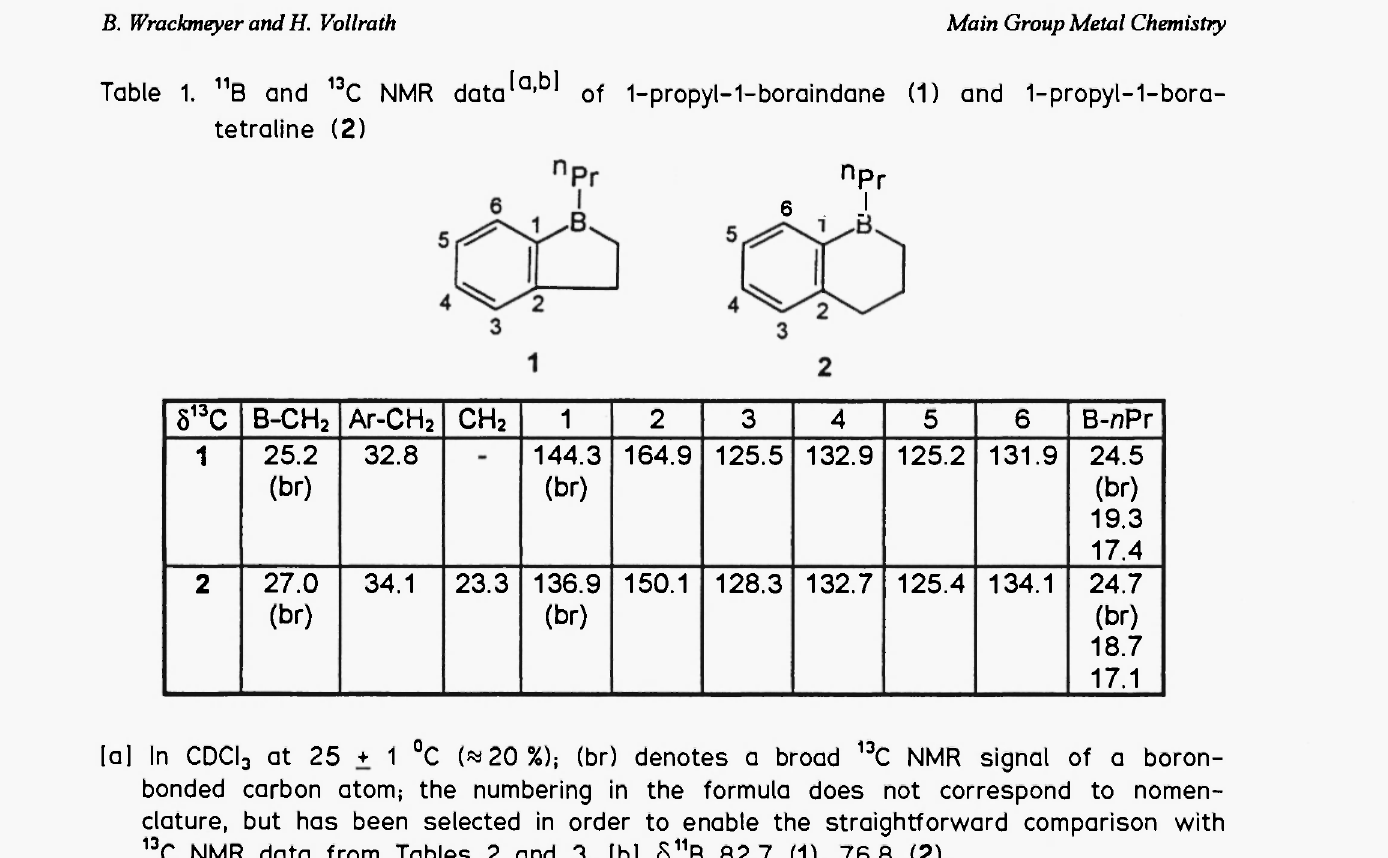
Table 1. 11 B and 13 C NMR data |a,bl